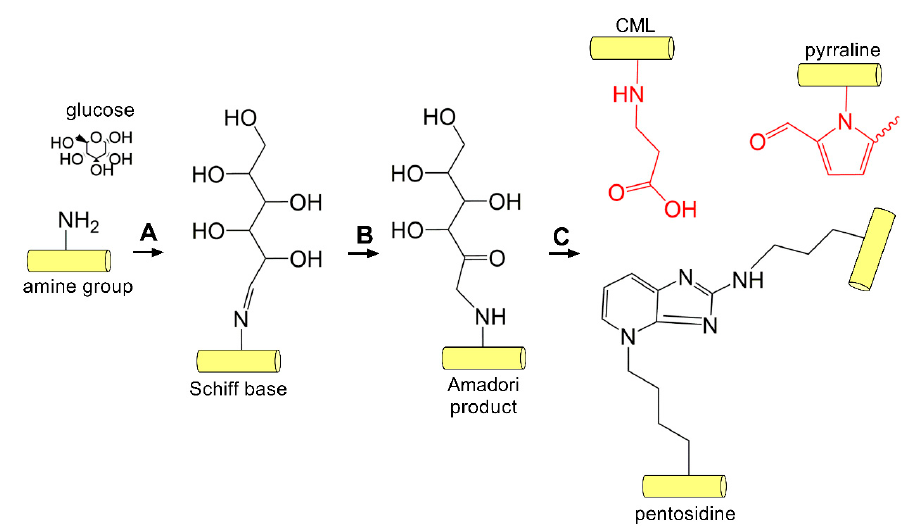
Figure 4. AGE-mediated crosslinking. ( A ) Glucose-mediated crosslinking begins via the Maillard reaction involving the addition of an aldehyde sugar to the amine group found on lysine or arginine side chains generating a Schiff base followed by ( B ) rearrangement to the Amadori product. ( C ) AGE adducts (red, N6-carboxymethyllysine (CML) and pyrraline) and inter- and intramolecular crosslinks (pentosidine) form on collagen within the cornea [178,179] .